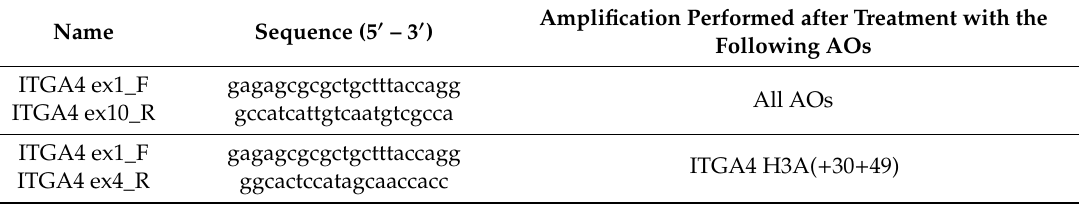
Table 3. List of primers used in this